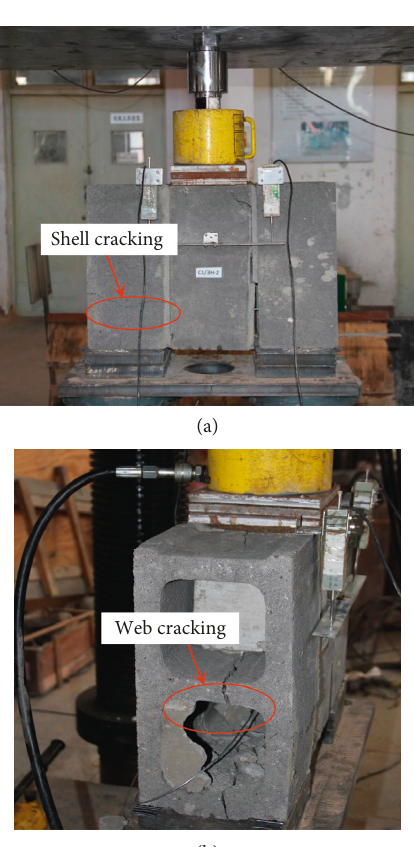
Figure 10: Shell and web cracking.